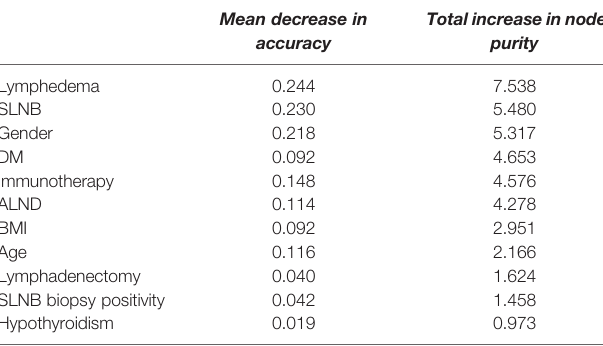
TABLE 3 | Variable importance in patients with upper limb melanoma.